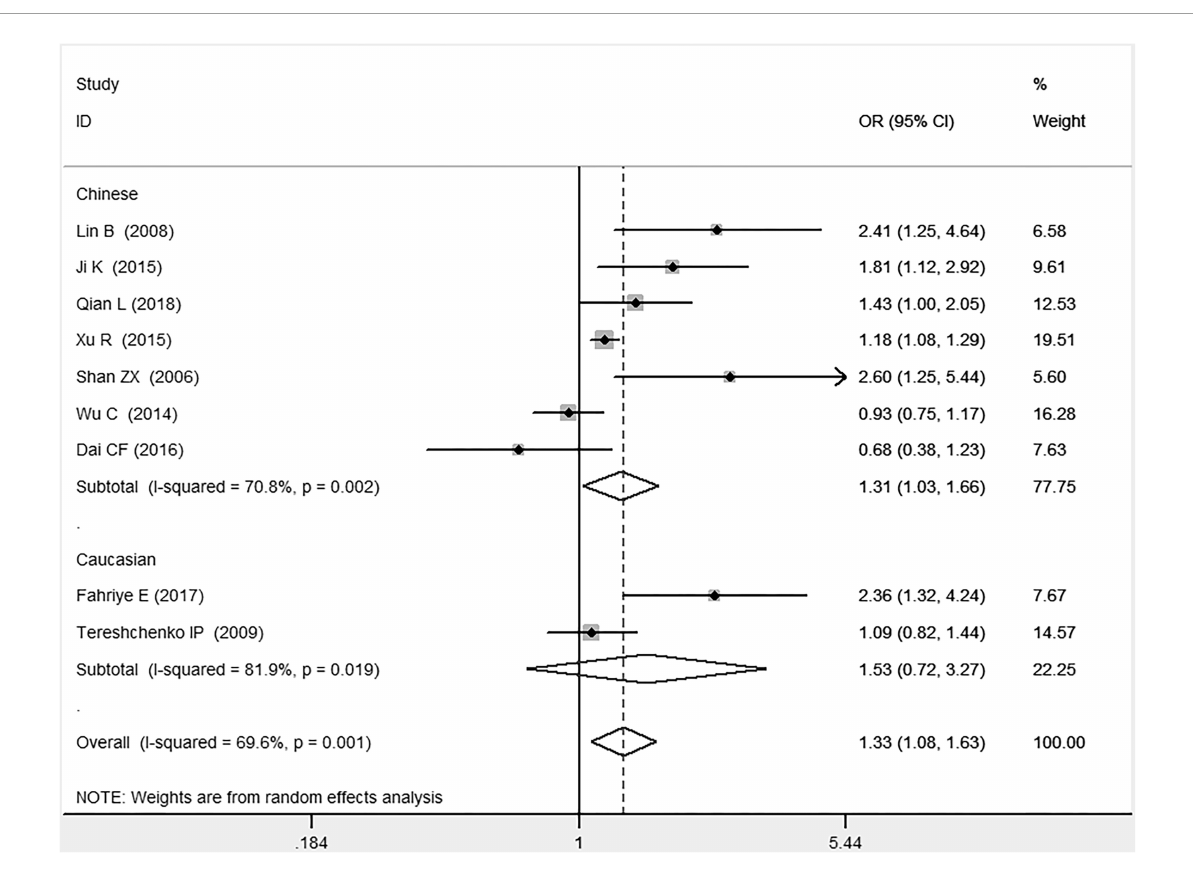
FIGURE6 Forest plot of CAD associated with MIF gene rs755622 G/C polymorphism under an additive genetic model (i.e., C allele vs. G allele of MIF gene rs755622 G/C